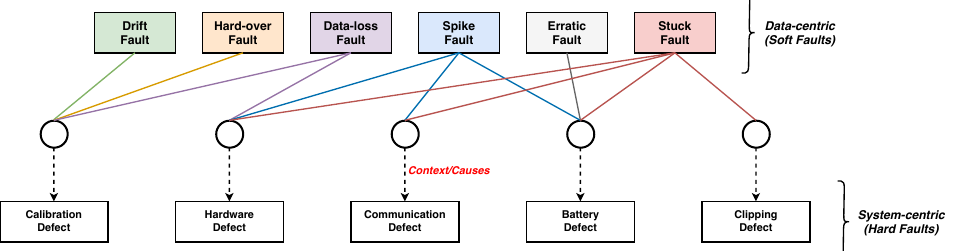
Figure 4. Representation of abnormal sensor behaviors (or faults) according to the context.